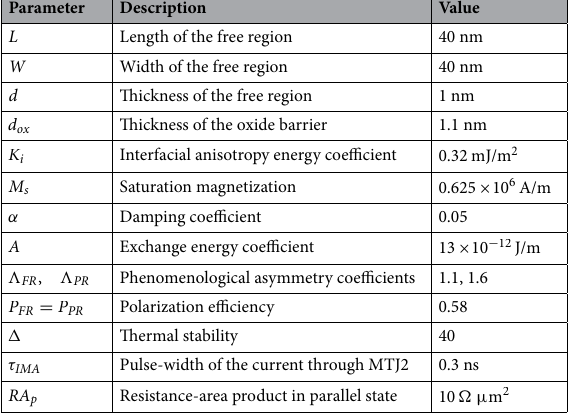
Table 1. Simulation parameters 30 used for performance evaluation. For a fair comparison, it was assumed that CMTJ and LDMTJ have identical FRs with the same